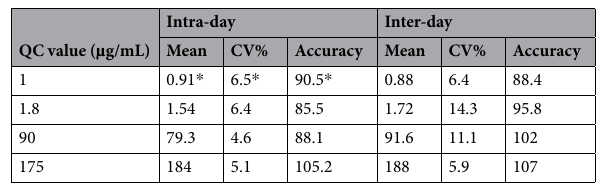
Table 4. Inter-day precision (CV%) and accuracy of cetuximab quantification. Results from HT4 (A) and LT3 (B)